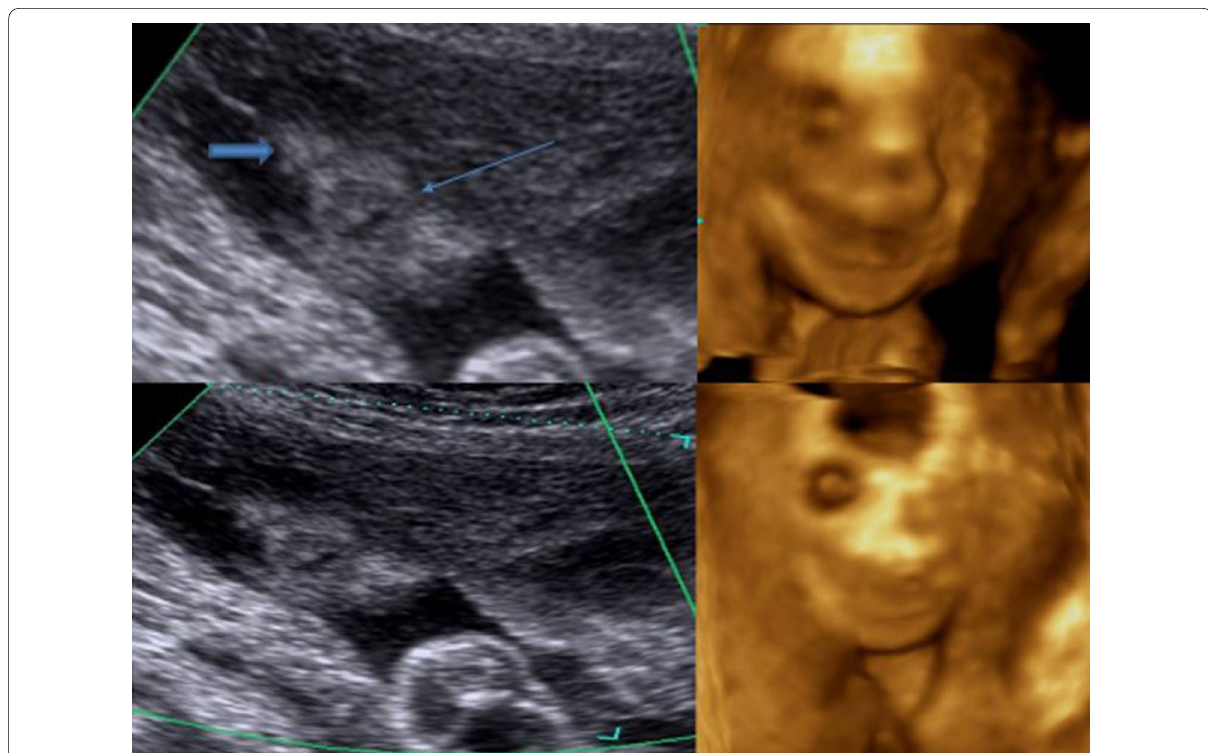
Fig. 3 Decreased amniotic fluid effect; 24 weeks gestational age fetus shows that the nose [arrow head] and lips [arrow] could be seen in the 2D image, and no details could be depicted from the 4D